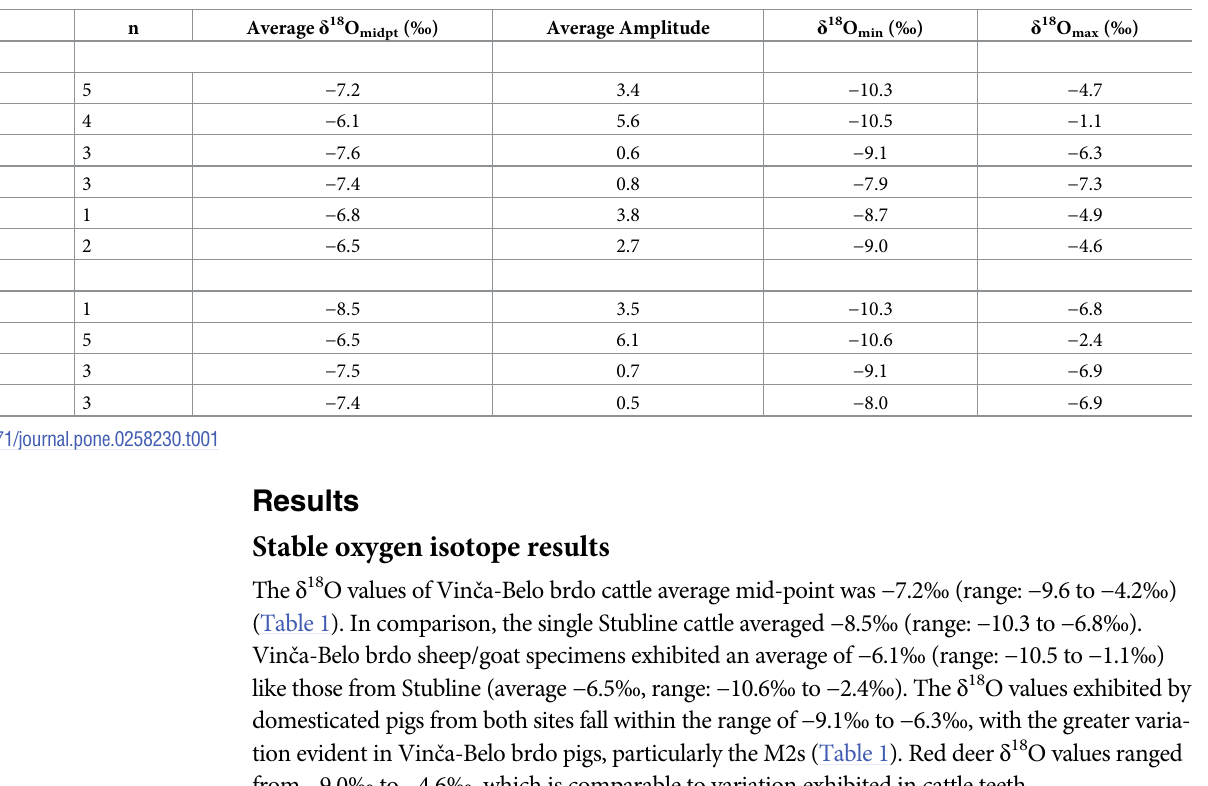
(Table 1). In comparison, the single Stubline cattle averaged − 8.5‰ (range: − 10.3 to − 6.8‰). Vin č a-Belo brdo sheep/goat specimens exhibited an average of − 6.1‰ (range: − 10.5 to − 1.1‰) like those from Stubline (average − 6.5‰, range: − 10.6‰ to − 2.4‰). The δ 18 O values exhibited by domesticated pigs from both sites fall within the range of − 9.1‰ to − 6.3‰, with the greater varia- tion evident in Vin č a-Belo brdo pigs, particularly the M2s (Table 1). Red deer δ 18 O values ranged from − 9.0‰ to − 4.6‰, which is comparable to variation exhibited in cattle teeth.